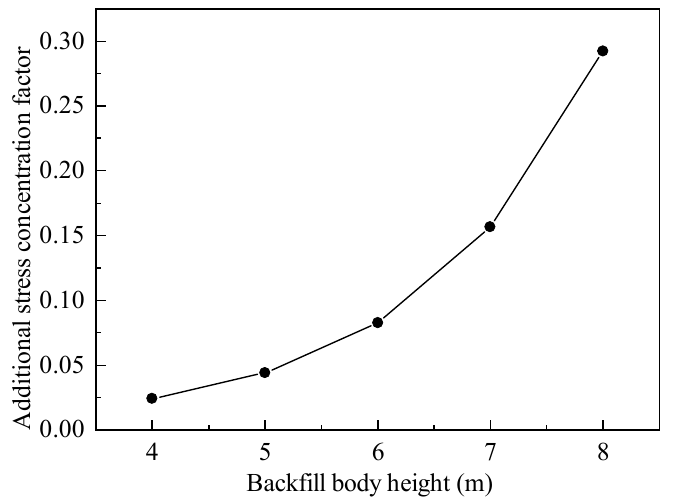
Figure 10. Additional stress on the central axis of coal pillars with different backfill body heights.